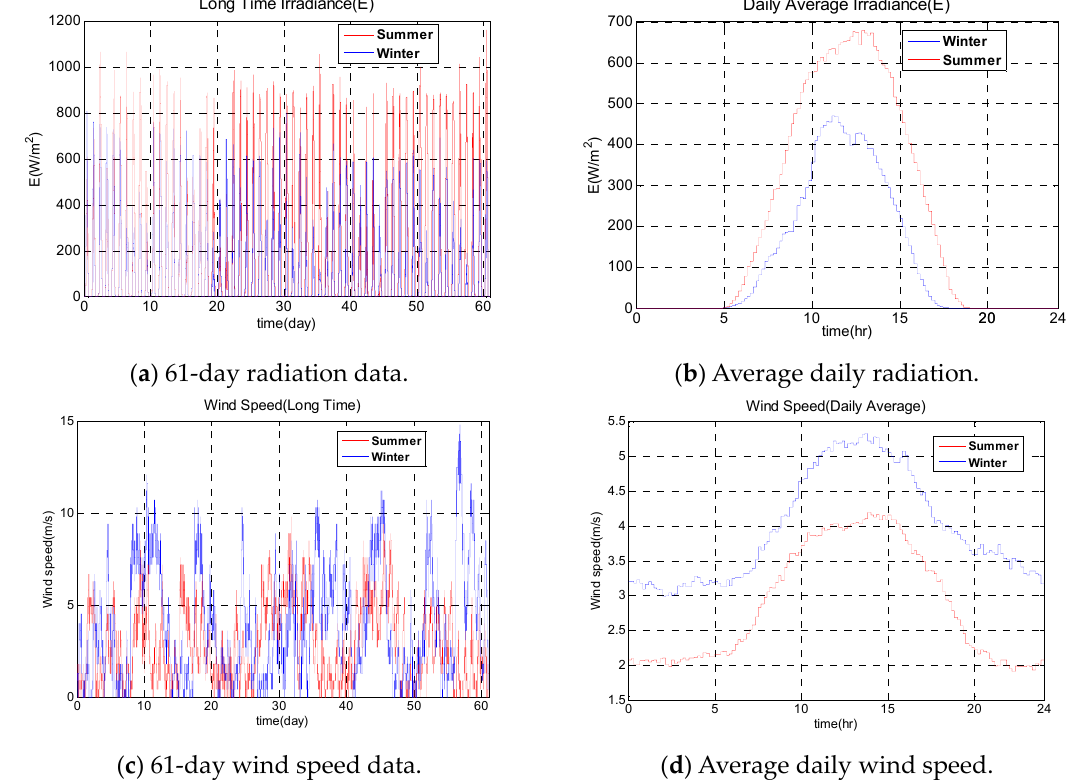
Figure 4. Radiation and wind data.